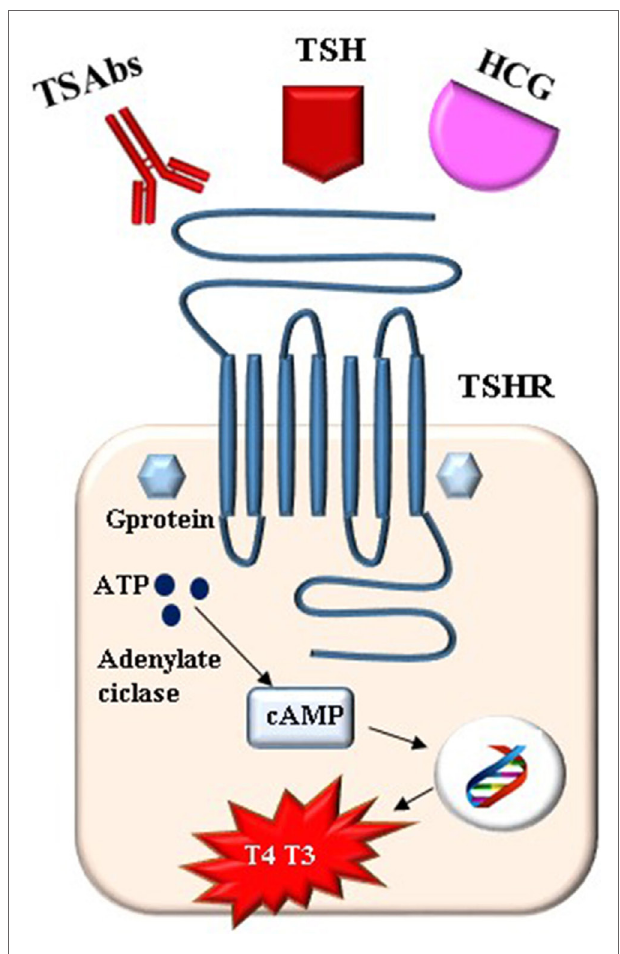
FiGURe 1 | The stimulation of TSH receptor (TSHR) in